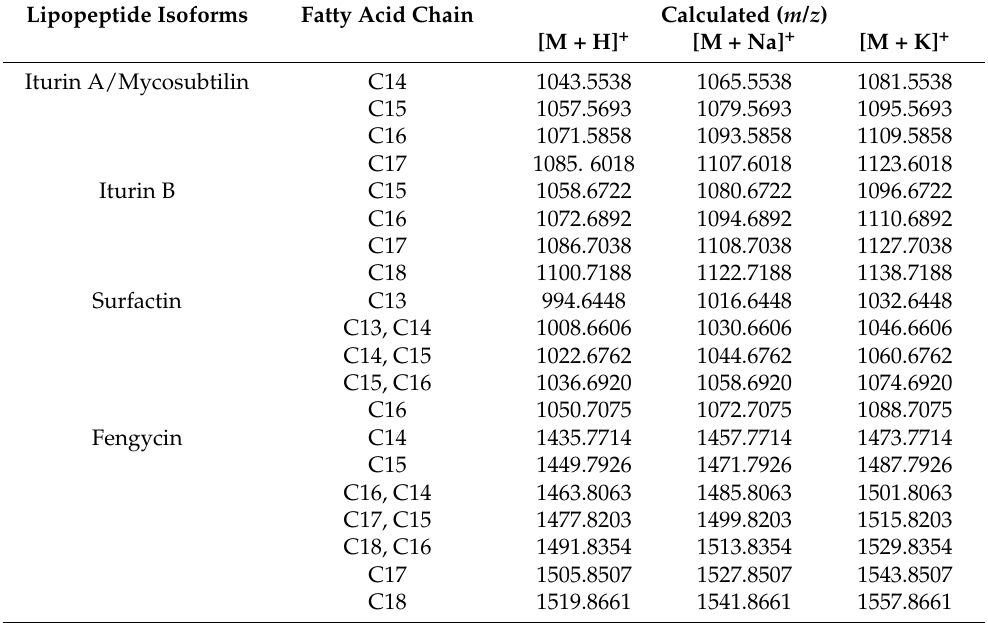
Table 3. Primary peaks detected by LC–MS analysis of the lipopeptides produced by strain F9. Lipopeptide Isoforms Fatty Acid